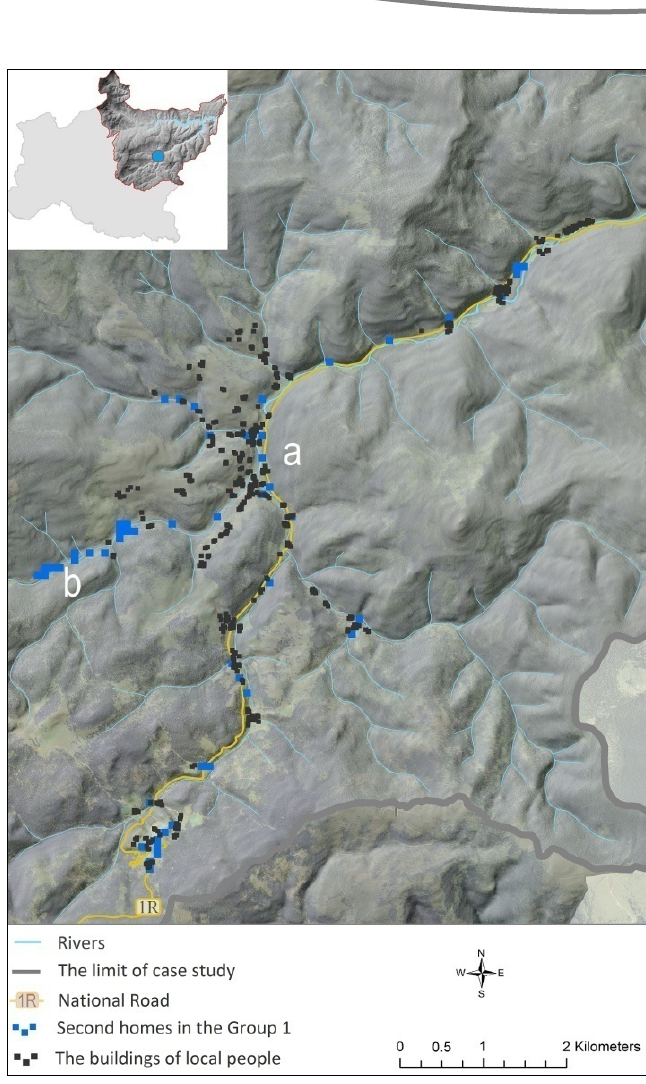
Figure 3: The spatial distribution of the group 1 in the case of Poiana Horea village (Beliș Commune, Cluj